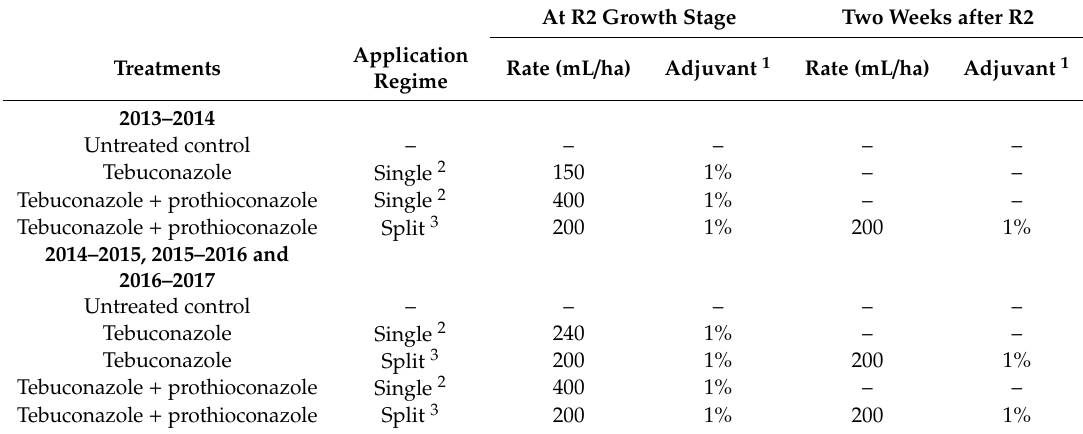
Table 1. Fungicide treatments and application regimes for each season of field experiments. At R2 Growth